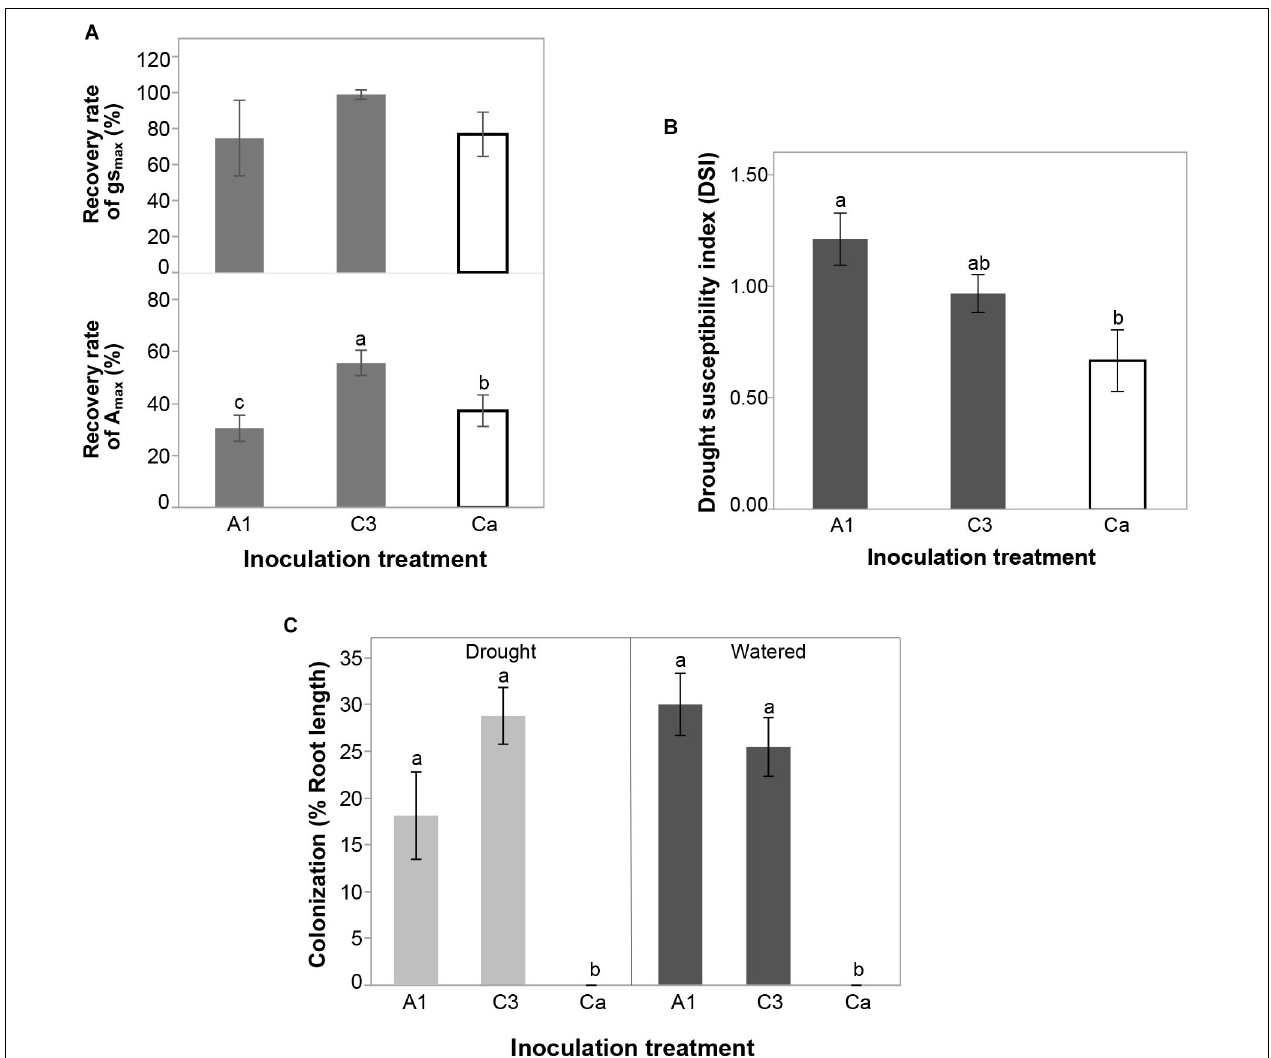
FIGURE 5 | (A) Effect of inoculation with R. irregularis isolates A1 and C3 on the recovery rate of stomatal conductance (g smax ) and photosynthetic capacity (A max ) during re-watering period in plants that had been subjected to drought in Experiment 2. (B) Effect of inoculation with R. irregularis isolates A1 and C3 on the drought susceptibility index (DSI) of cassava in Experiment 2. (C) Effect of inoculation with R. irregularis isolates A1 and C3 on AMF colonization (% root length) in water-stressed (drought) and well-watered (watered) conditions in Experiment 2. Error bars represent ± S.E. Different letters above bars represent significant differences at p < 0.05 according to a Tukey post-hoc